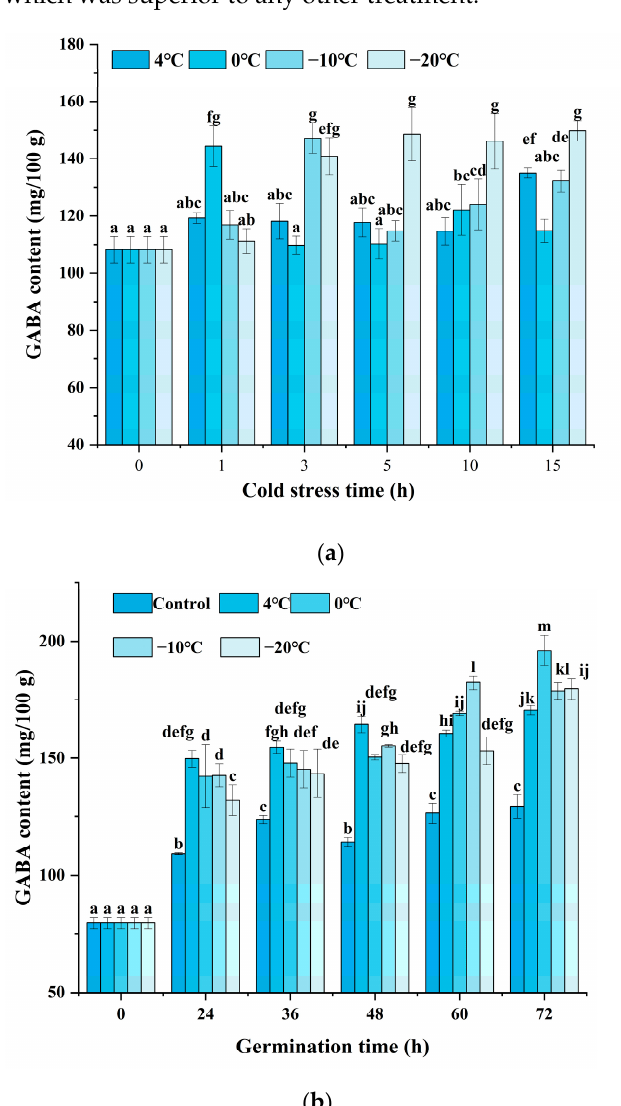
Figure 2. Change in GABA content in fl uenced by cold stress and germination: ( a ) represents the change in GABA content in fl uenced by cold stress temperatures 4 °C, 0 °C, − 10 °C, and − 20 °C and subjected to cold stress at 4 °C, 0 °C, − 10 °C, and − 20 °C, respectively, and germinated for 24 h; ( b ) represents the change in GABA content in fl uenced by cold stress temperature and germination time; control, germinated for 0–72 h without cold stress; 4 °C, subjected to cold stress at 4 °C for 15 h and germinated for 0–72 h; 0 °C, subjected to cold stress at 0 °C for 1 h and germinated for 0–72 h; − 10 °C, subjected to cold stress at − 10 °C for 3 h and germinated for 0–72 h; − 20 °C, subjected to cold stress at − 20 °C for 5 h and germinated for 0–72 h. Means with di ff erent small le tt er superscripts are signi fi cantly di ff erent at p < 0.05.